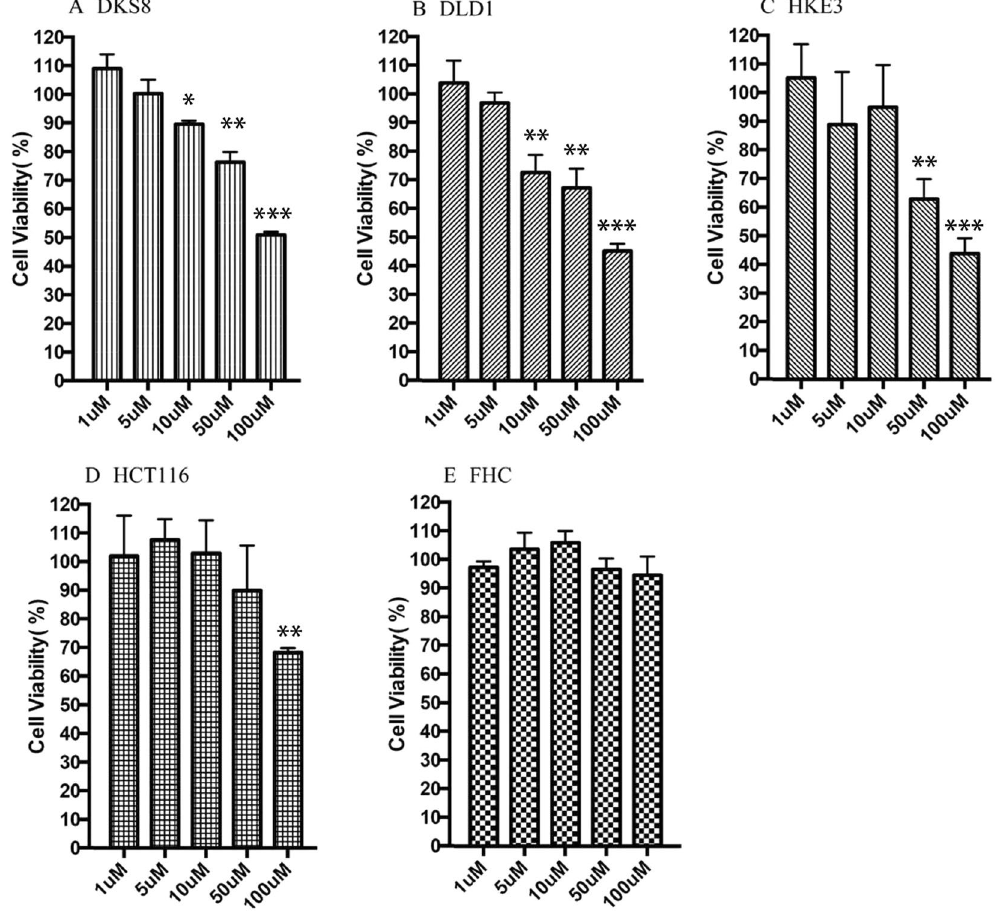
Figure 4. Dose-dependent anti-cancer activity of PE-BBI, ranging from 1 to 100 µ M, against different human colorectal cancer cell lines (A) DKS8 (B) DLD-1 (C) HKE3 (D) HCT116 (E) FHC. The IC 50 values against four cancer cell lines after 24 h incubation, were 50.1 µ M, 9.8 µ M, 35.4 µ M, 50.2 µ M, respectively. Meanwhile, PE- BBI didn’t show any cytotoxicity against human normal endothelial cell lines FHC. Data points in each panel represent the mean and SD of values obtained for 9 replicates. Significant differences were marked with asterisks ( * P < 0.05; ** P < 0,01; *** P <